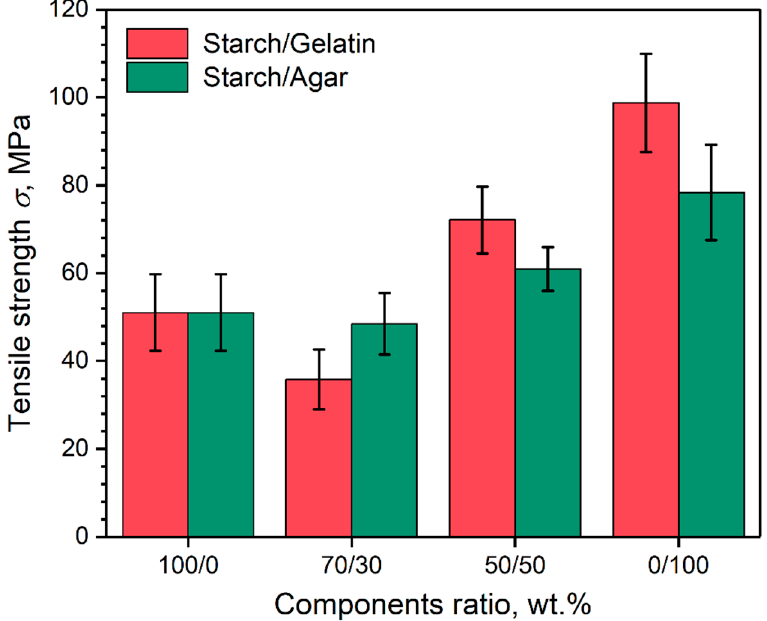
Figure 6. Tensile strength of the coatings depends on their composition.